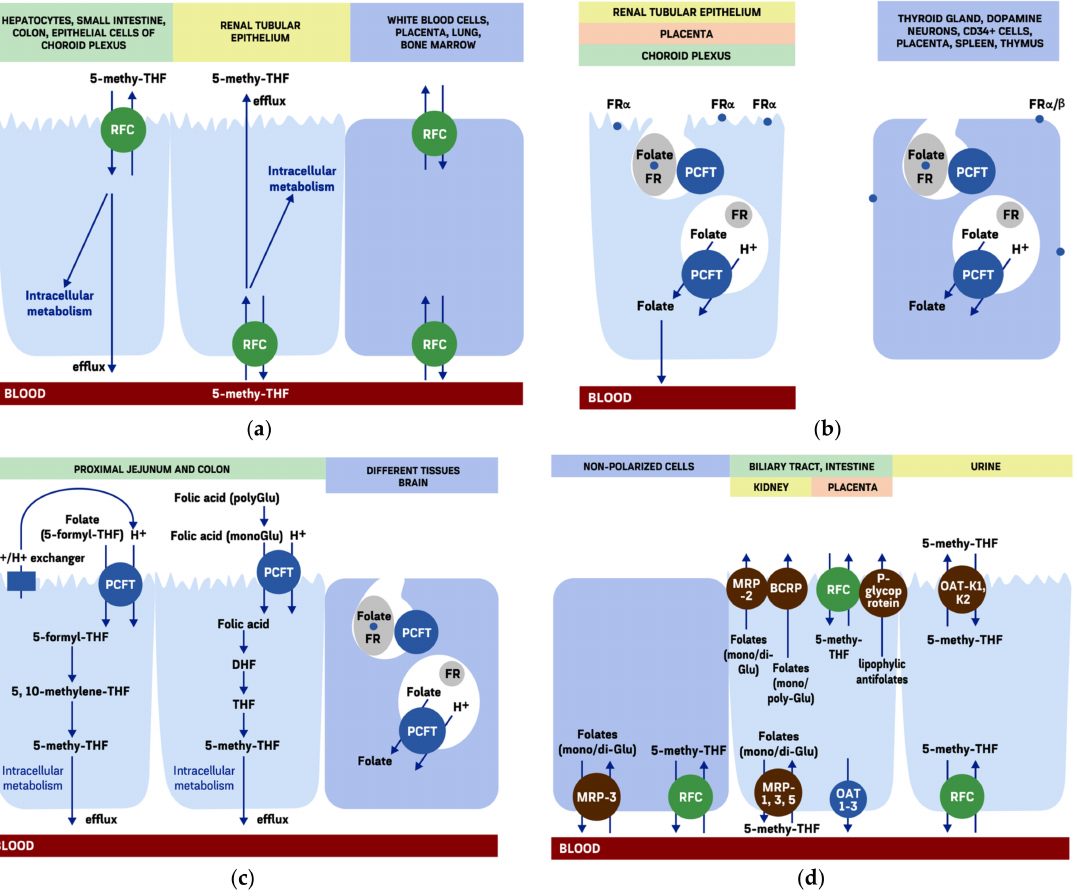
Figure 2. Schematic location and functioning of cellular folate transporters: ( a ) reduced folate carrier (RFC), ( b ) folate receptors (FR), ( c ) proton-coupled folate transporter (PCFT), ( d ) efflux pumps—multidrug resistance proteins (MRP), organic anion transporters (OAT), breast cancer resistance protein (BCRP). An apical surface of polarized epithelial cells is marked by irregular contour. In non-FR α -mediated transport, 5-methyl-THF rapidly converts into polyglutamates while in FR α -mediated transport it is rather moved